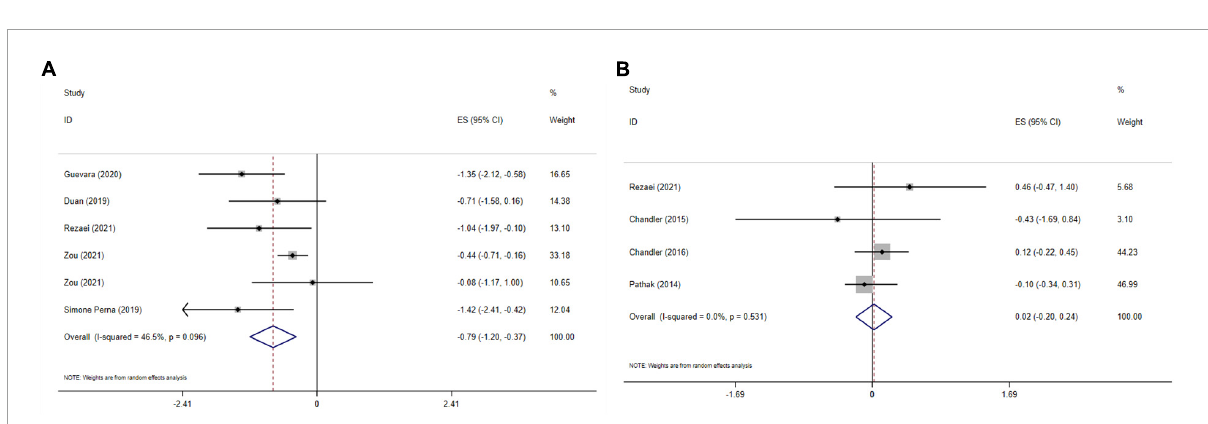
FIGURE4 The effects of vitamin D supplementation on WC (A) , and fat mass (B) are depicted in a forest plot with mean differences and 95 percent confidence intervals